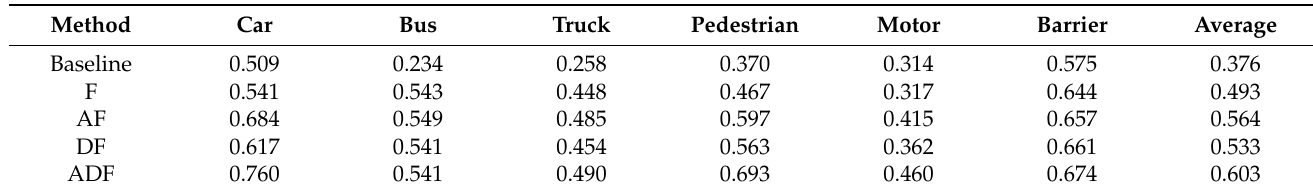
Table 5. Class-based ablation study results on nuScenes test set.